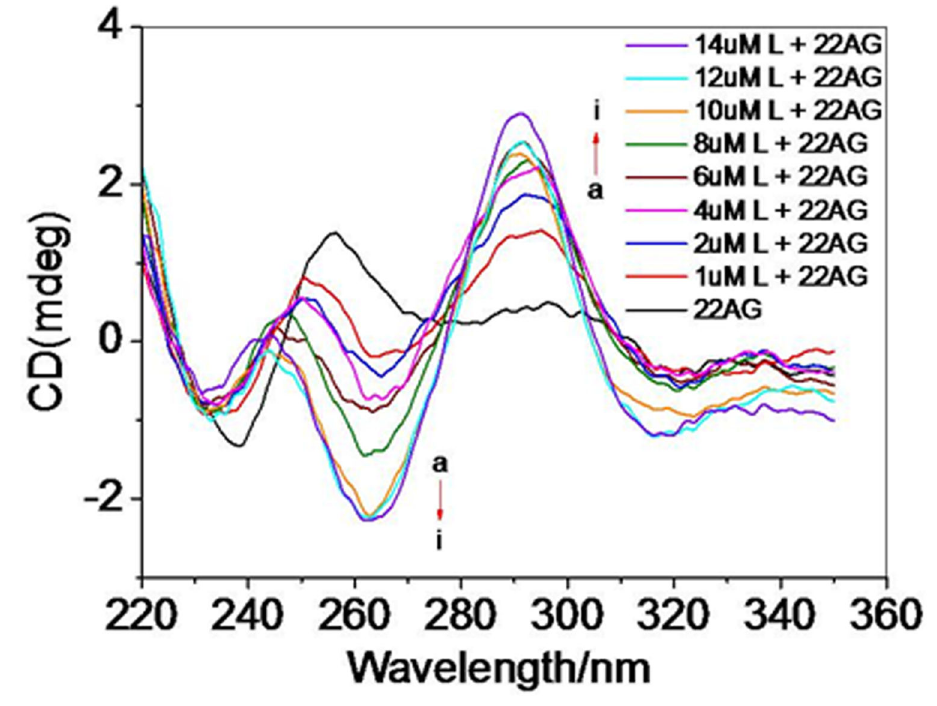
Figure 3. CD titration of 22AG with complex in 10 mM Tris buffer. CD titration spectra of 22AG 20 µM in 10 mM Tris-HCl: with (a) 0 µM, (b) 1µM, (c) 2 µM, (d) 4 µM, (e) 6 µM, (f) 8 µM, (g) 10 µM, (h) 12 µM, (i) 14 µM [(dmb) doi: